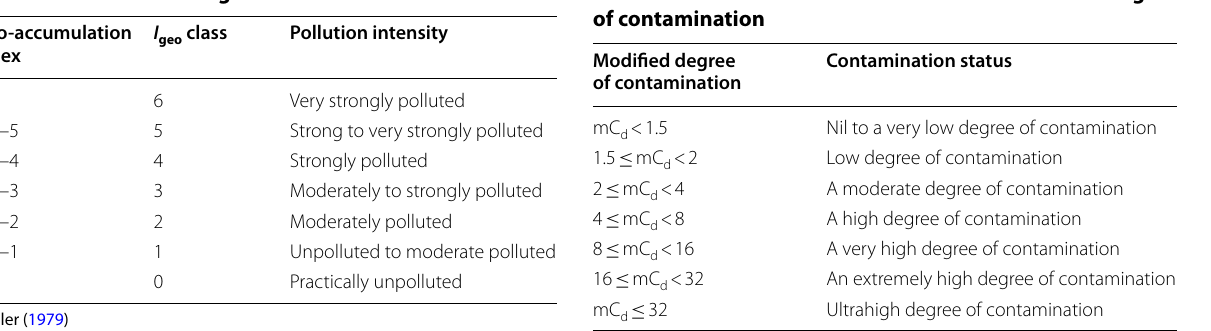
Table 4 Classification of geo-accumulation index